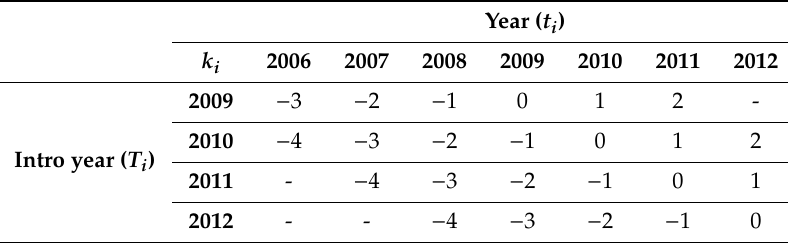
Table 2. Year markers used to estimate dynamic e ff ects of POCT, 2006–2012.